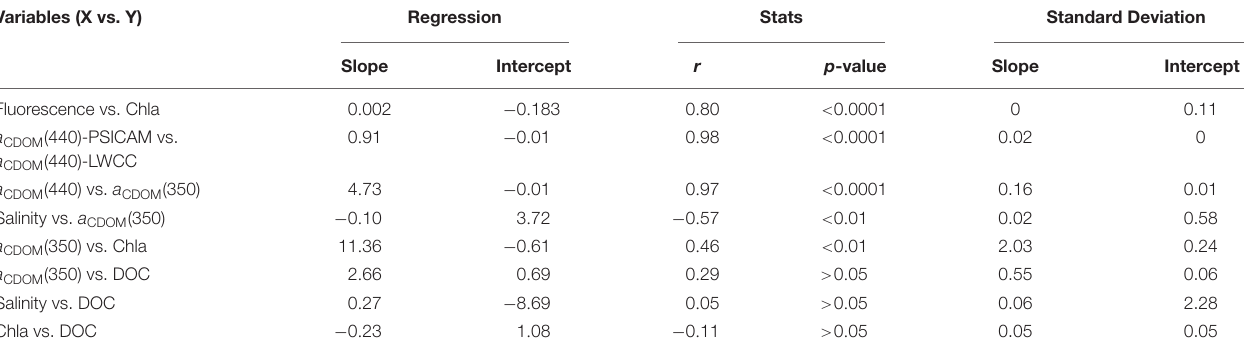
TABLE 2 | Results of the linear regressions applied to different pairs of variables in this study. For all the cases, n = 45. Variables (X vs. Y) Regression Stats Standard Deviation Slope Intercept r p -value Slope Intercept 0 . 002 − 0 . 183 0 . 80 < 0 . 0001 0